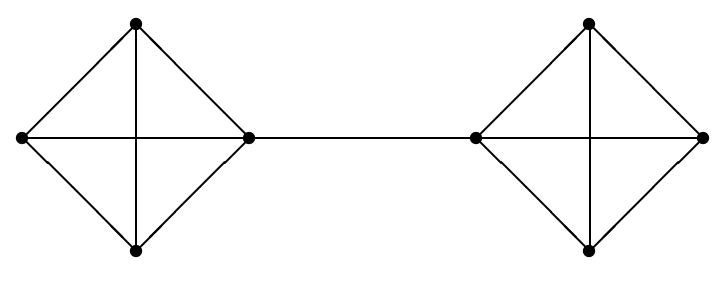
Figure 2. A small-world